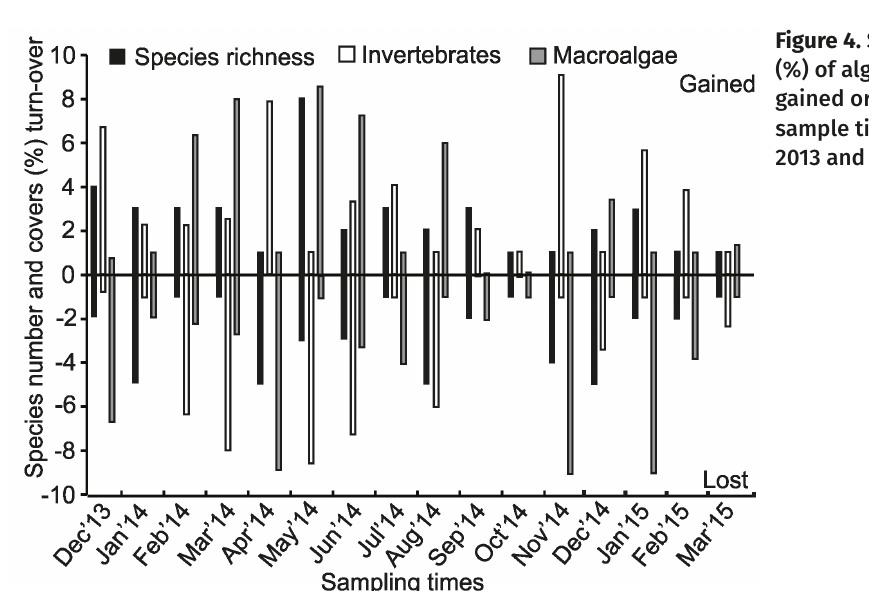
Figure 4. Species richness and cover (%) of algal and invertebrate taxa gained or lost between successive sample times between December 2013 and March 2015.